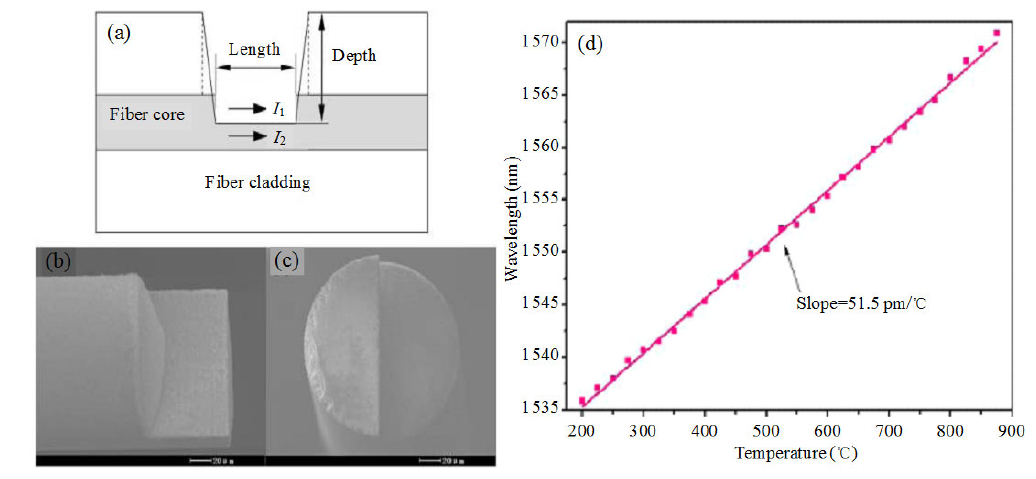
Fig. 22 Schematic diagrams of MZI based on a air hole fabricated by fs laser pulses and its temperature response